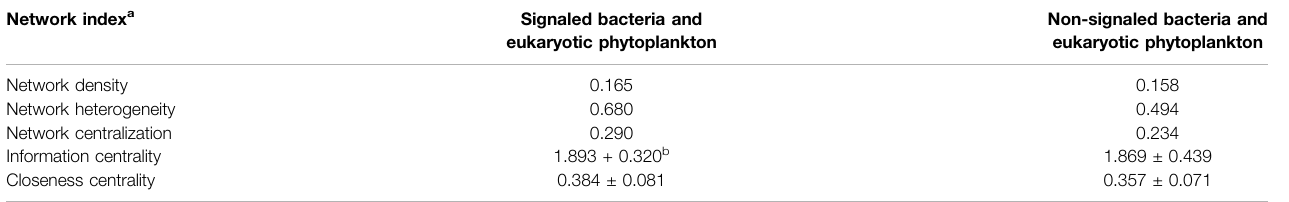
TABLE 2 | Characteristics of networks between bacteria and eukaryotic phytoplankton. Network index a